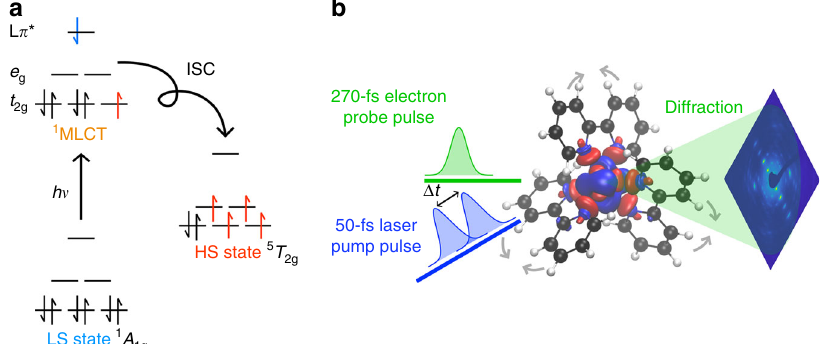
Fig. 1 SCO and schematic of the ultrafast electron diffraction setup. a Schematic electronic con fi gurations for the SCO model system BPY following the Pauli principle and Hund ’ s rules 11 . After the initial photoexcitation from the low spin (LS) state into the MLCT state, the system decays to the high spin (HS) state through a number of intersystem crossings (ISC). b Schematic of the experimental beam interactions using variable time delays ( Δ t ) to catch the structural changes. The driving force is the change in electron density during SCO as shown in the fi gure. Single crystal BPY was investigated by ultrafast electron diffraction in a pump-probe experiment with 400-nm excitation and 95 keV electron probe pulses. The time resolution achieved is (270 ± 30) fs FWHM. Gray arrows show the changes in the nuclear con fi guration. Red denotes positive values for the electron density differences during SCO, and blue denotes the negative value for the electron density differences (see Supplementary Fig.